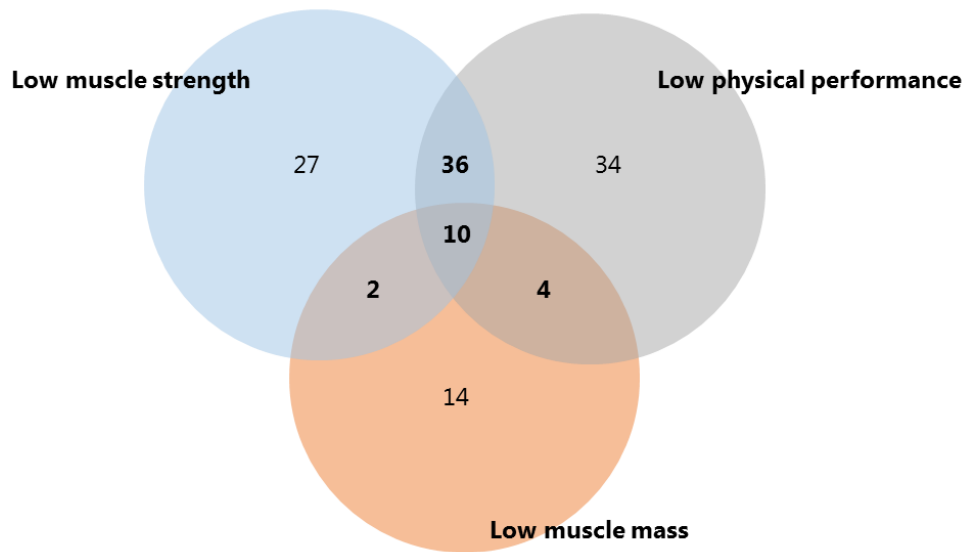
Figure 2. The occurrence of the sarcopenia components in the assessments. Co-occurrence of the components led to a number of 16 (2 + 10 + 4) for structural sarcopenia and 46 (36 + 10) assessments meeting the criteria for functional sarcopenia.